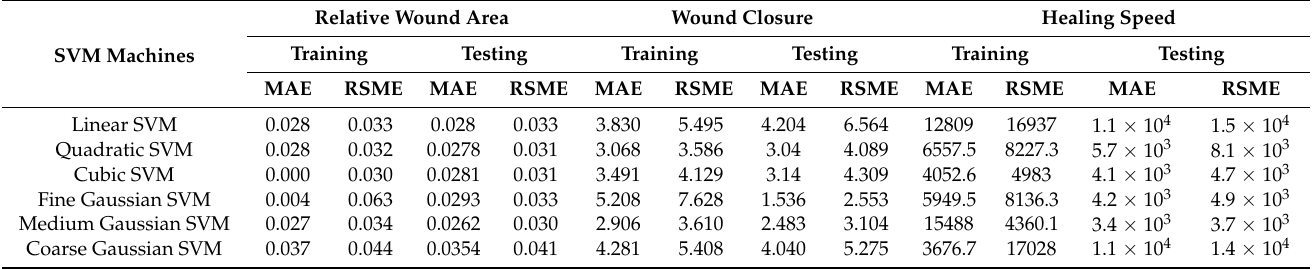
Table 2. The performance of different SVM learning algorithms in Regression Learner App.